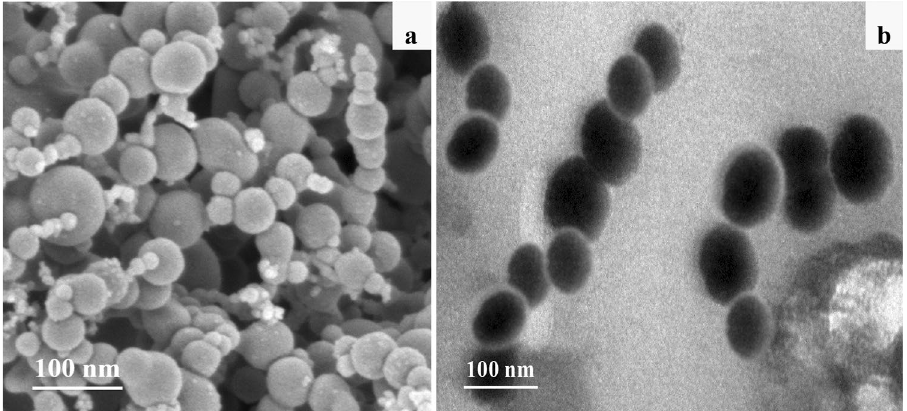
Figure 2. SEM image ( a ) and C-TEM image ( b ) of NZVI.